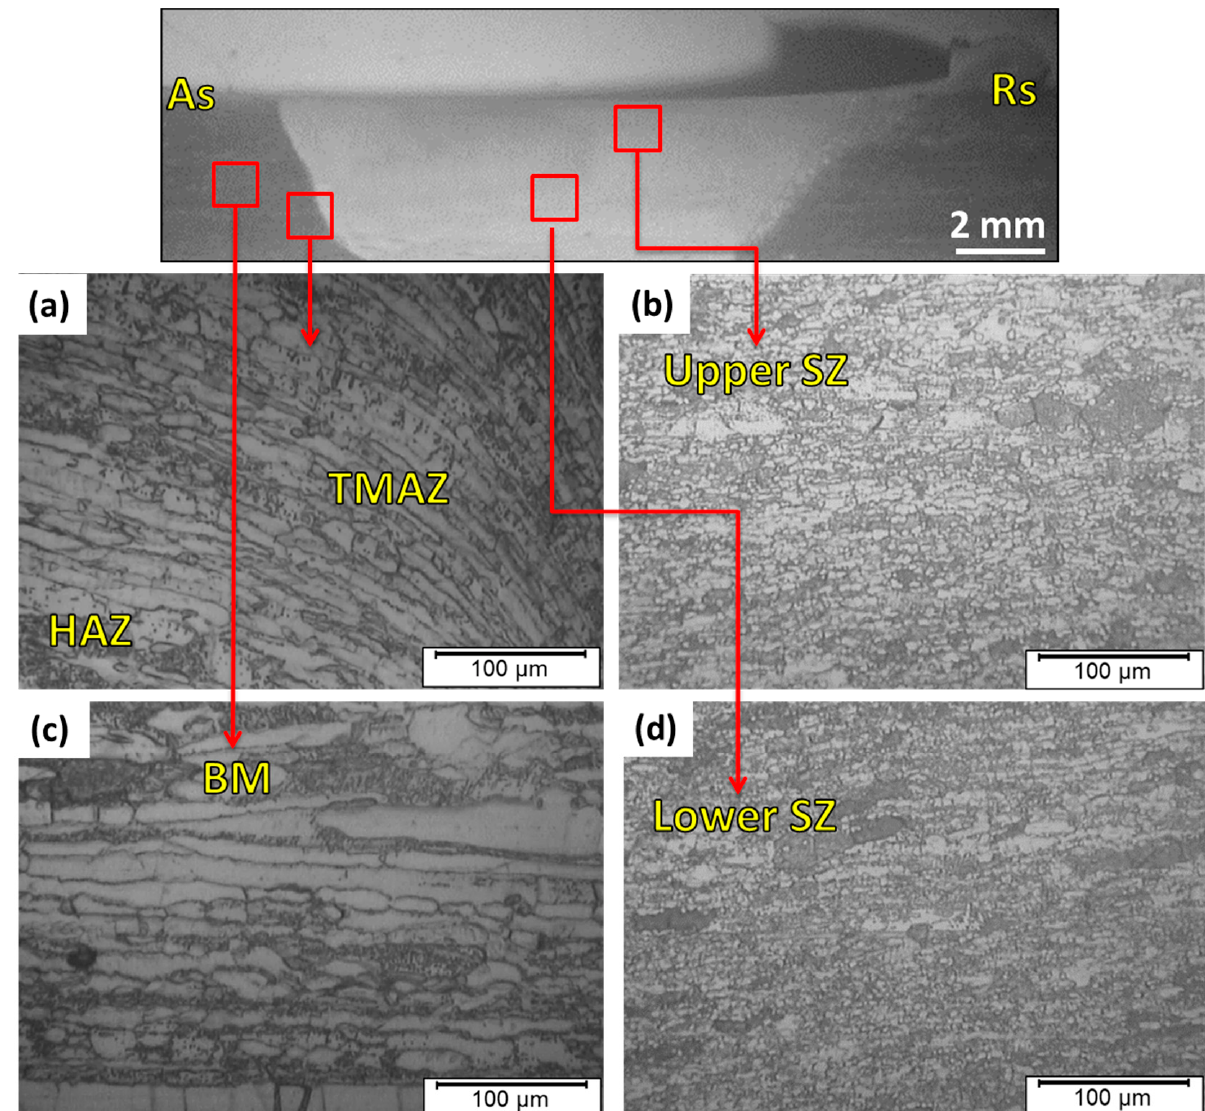
Figure 6. ( a ) Macrograph and ( b – d ) microstructure images of the different zones for FSWed butt joint of 2205 DSS welded at 600 rpm, 50 mm/min, and 14 KN.